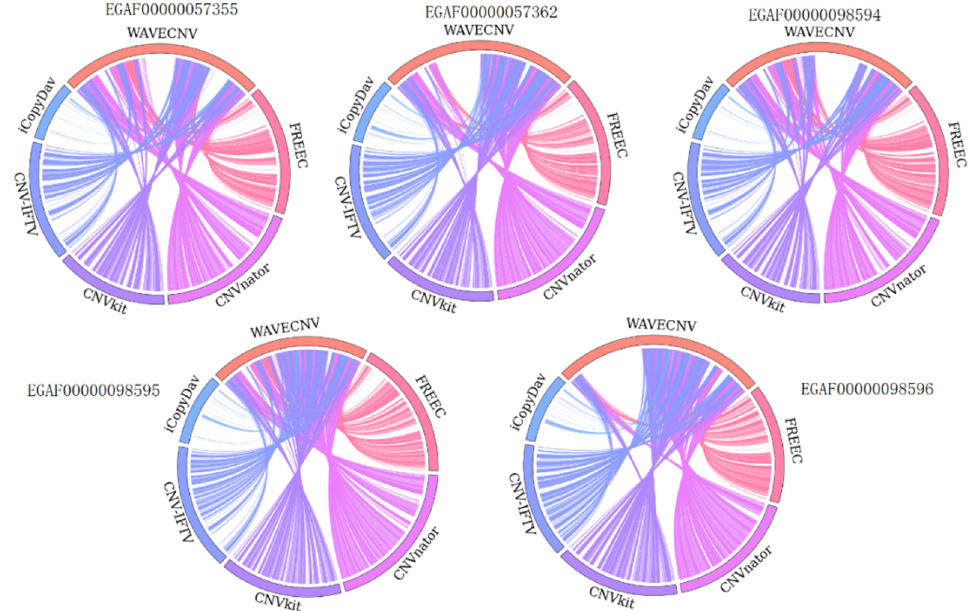
Figure 5. The length of the circle in the figure represents the total length of CNV detected by the six methods, and the connecting line in the circle represents the same CNV region detected by different methods.